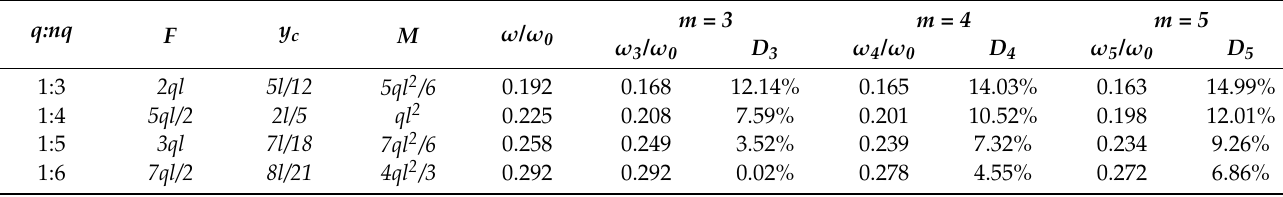
Table 4. Calculation results of the bending moment and deflection under trapezoidal load and concentrated